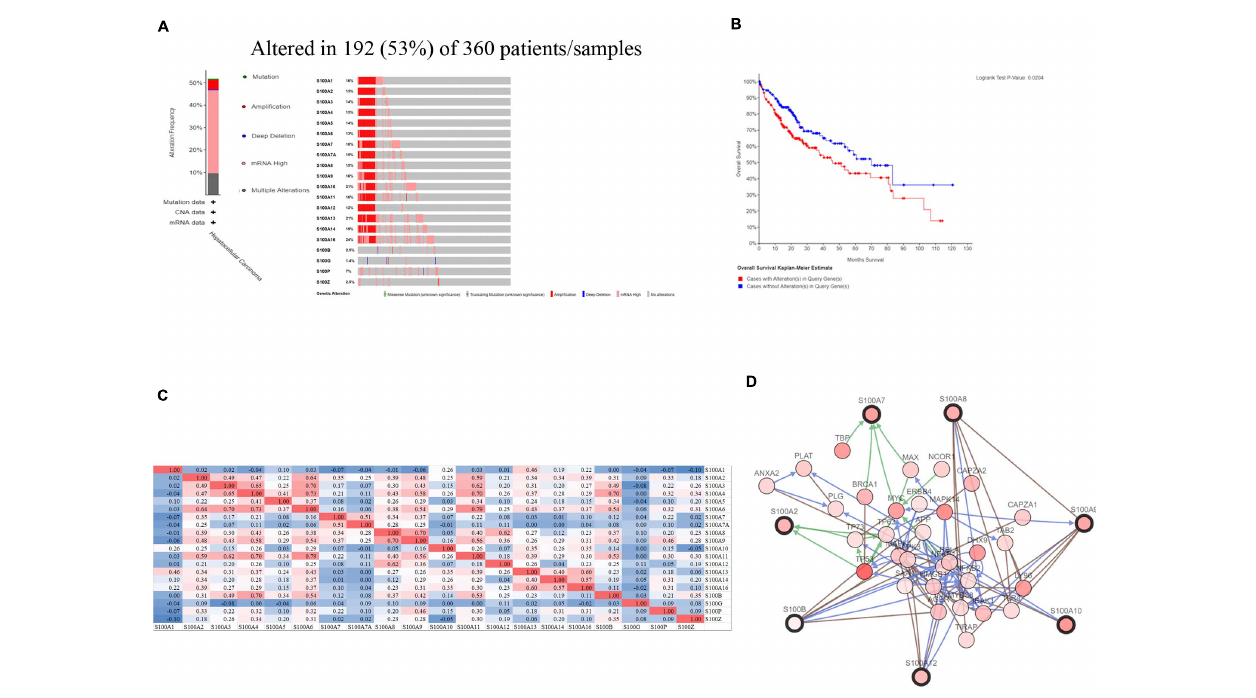
FIGURE 6 | S100s gene expression and mutation analysis in HCC (cBioPortal) (A) S100s gene expression and mutation analysis in HCC. (B) High genetic alterations (53%) in S100s were associated with shorter OS. (C) Correlation between different S100s in HCC (Positive correlations were shown as red color while negative correlations showed blue. The numbers in the cells represented their correlation coefficient). (D) The network for S100s and the 50 most frequently altered neighbor genes.